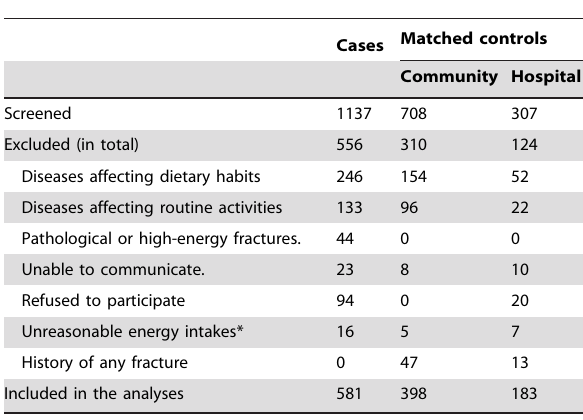
Table 1. Process of participant selection.